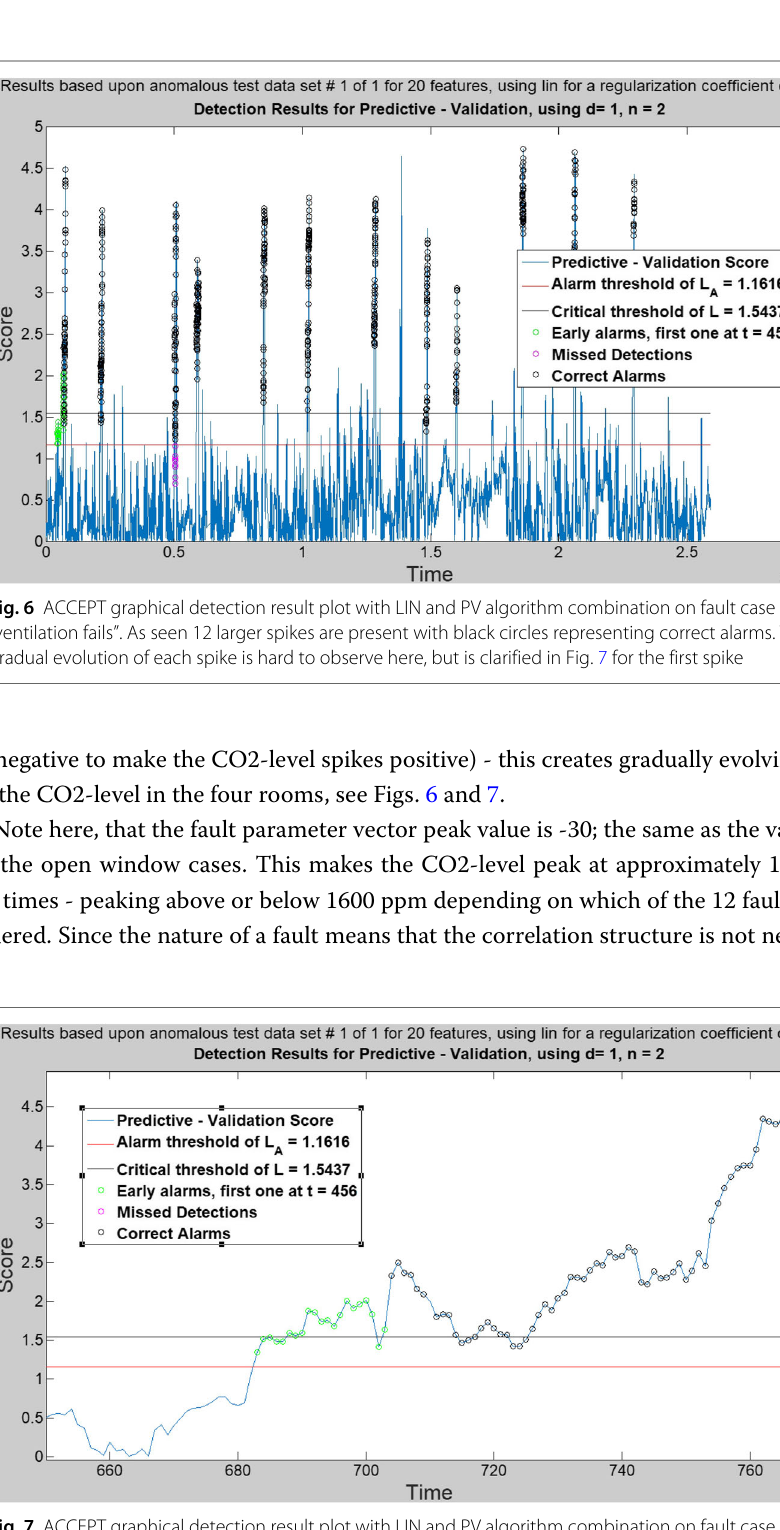
Fig. 7 ACCEPT graphical detection result plot with LIN and PV algorithm combination on fault case “ventilation fails”. As seen here the gradual evolution is non-linear (though tending to increase between fault start at 661 and fault end at 769) although the fault parameter vector is linear - that is due to the addition of the residual matrix (with small signal to noise ratio - SNR) in Eq. 12 as well as the possibility of the variable being to some extent non-linear with time even though it has been projected using only one score vector and containing high